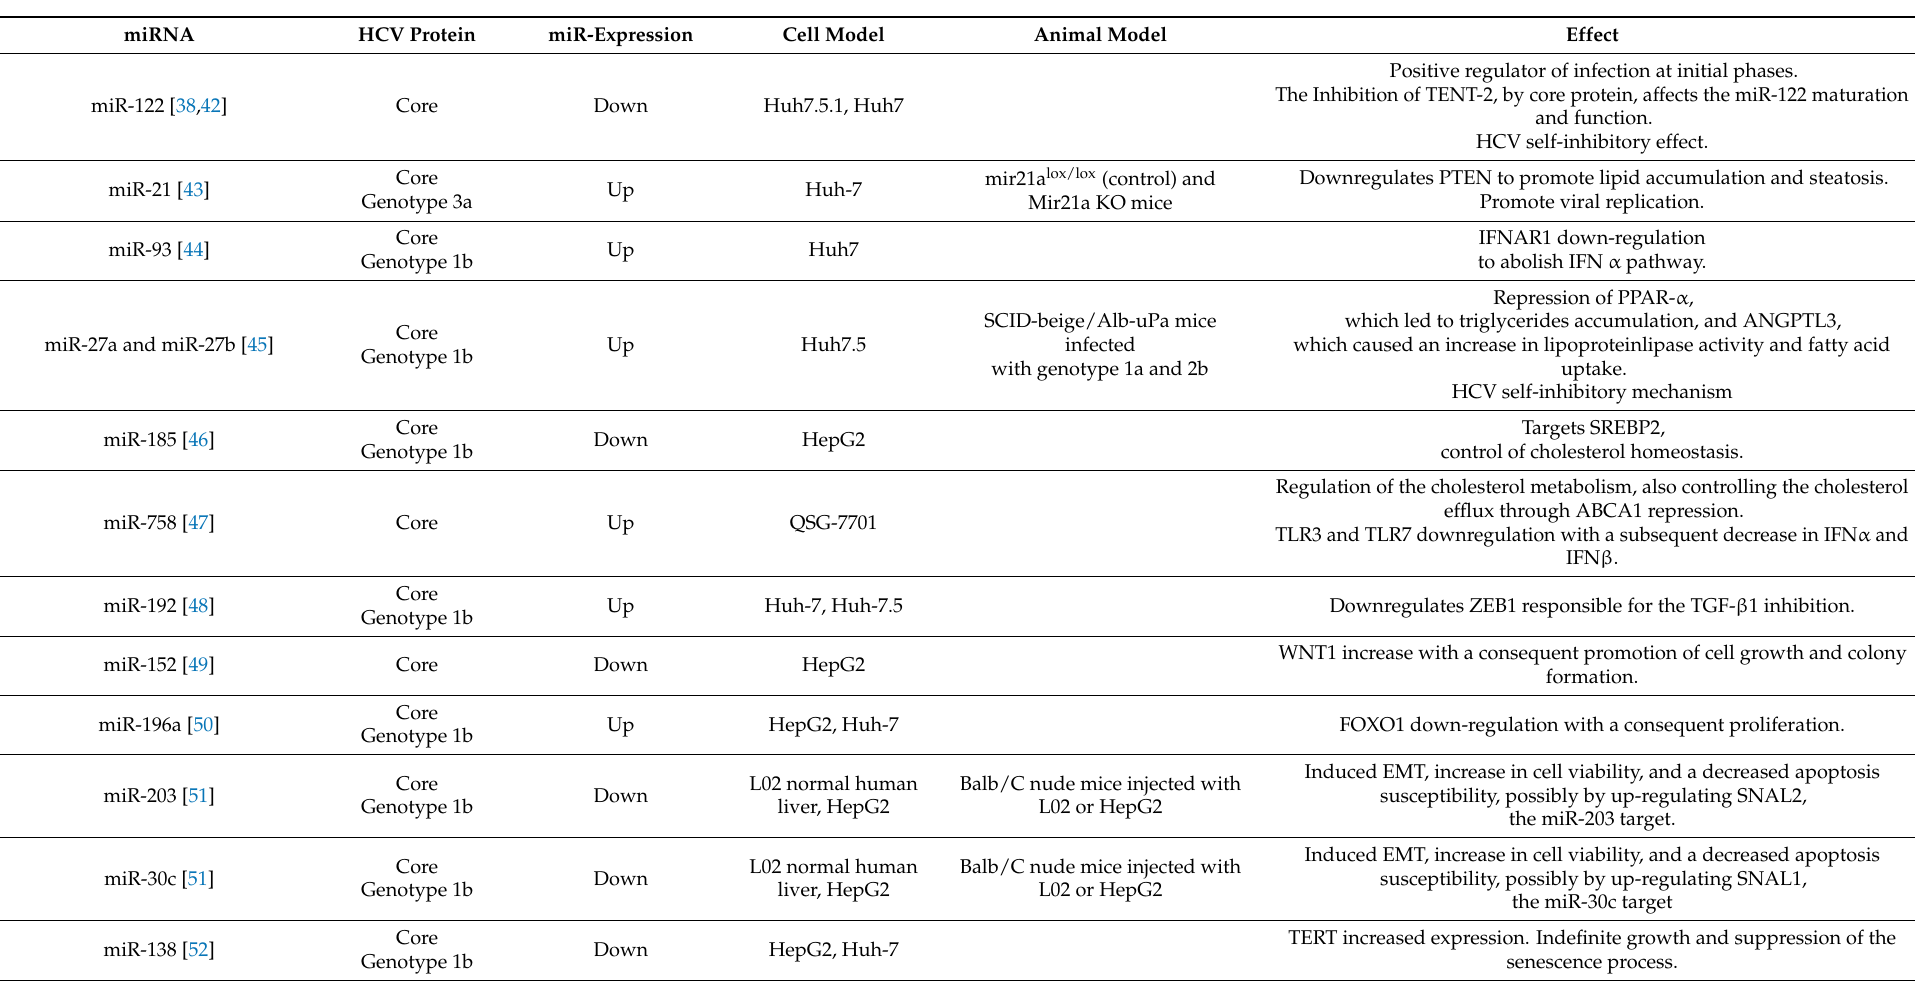
Table 1. List of cellular miRNA regulated by HCV core